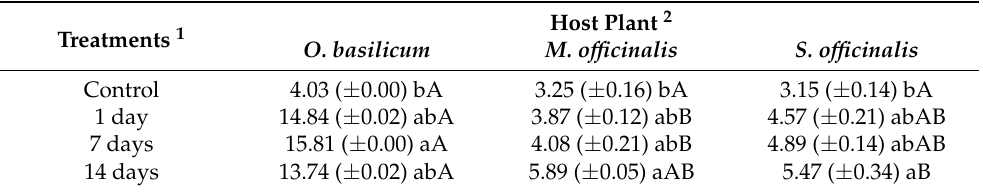
Table 4. Malondialdehyde concentration (nmol g − 1 FW) within leaves of Ocimum basilicum , Melissa officinalis and Salvia officinalis after Tetranychus urticae infestation. Treatments